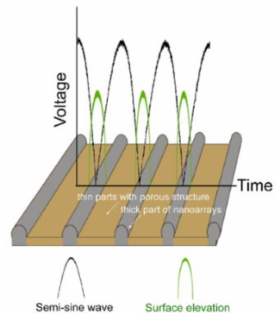
Figure 2. Schematic diagrams showing the periodic deposition process. The growth process at the lower and upper part of the semi-sine wave potential are corresponding to the deposition of thick and thin parts.